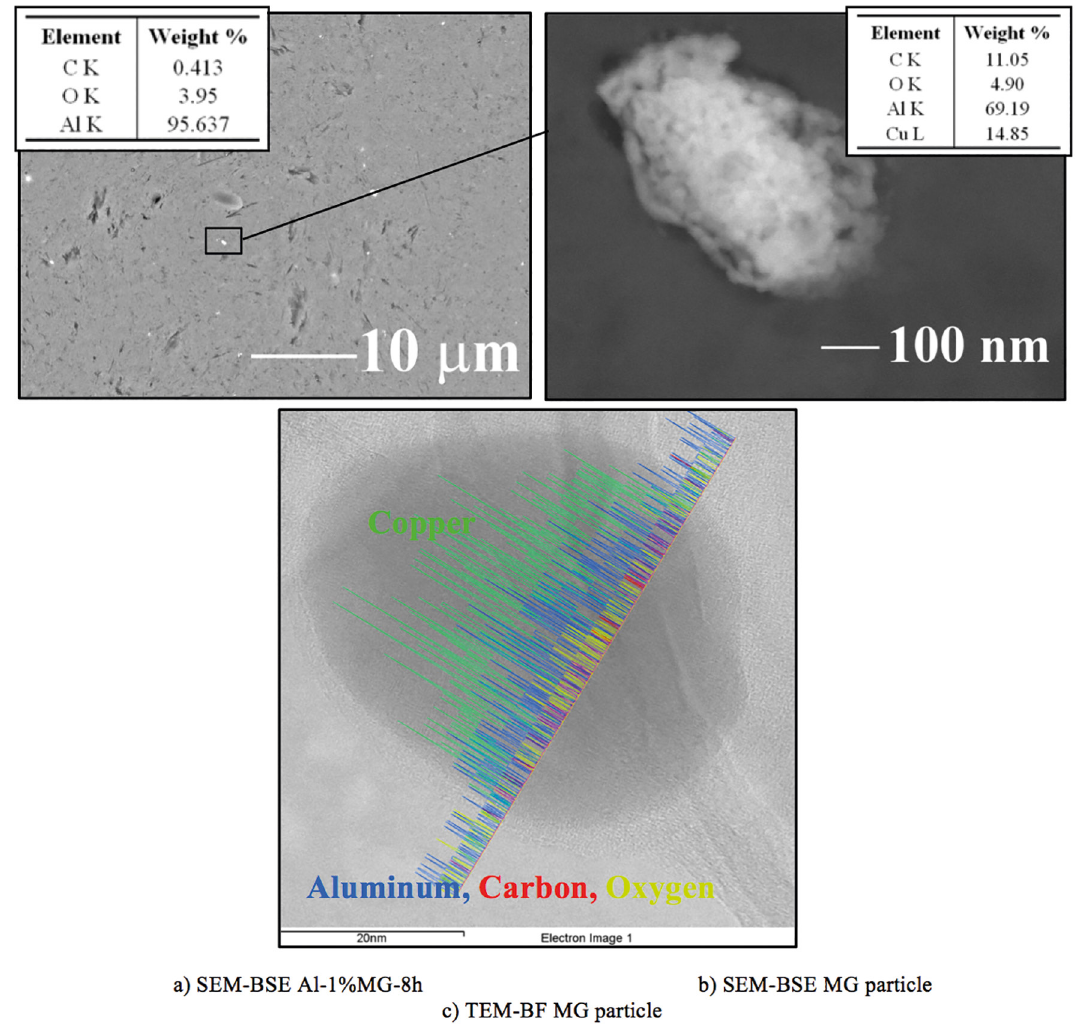
showing the chemical distribution of